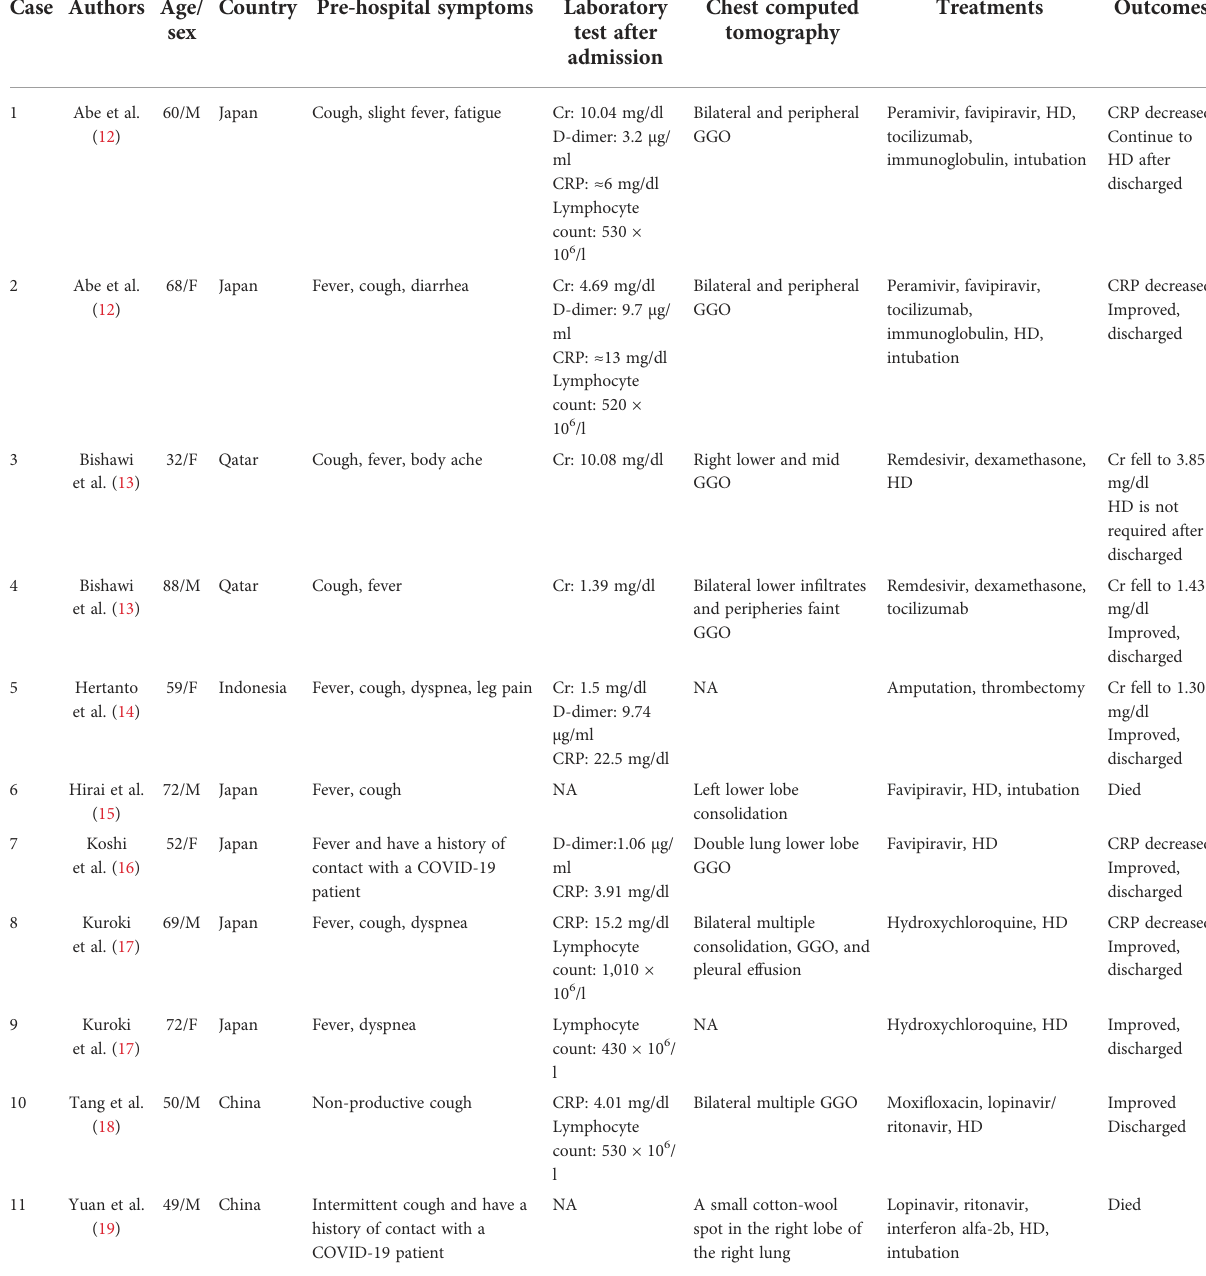
TABLE 1 Summary cases of DKD complicated with COVID-19